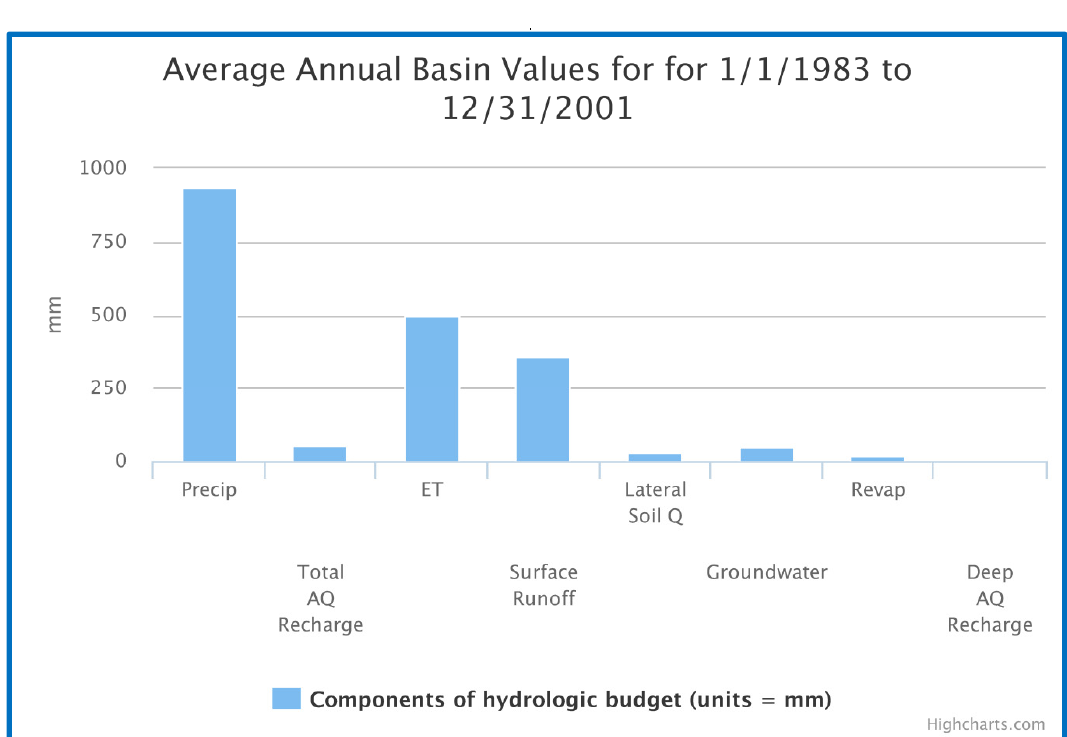
Figure 13. Average annual basin values for the hydrologic components for the Illinois River Basin.